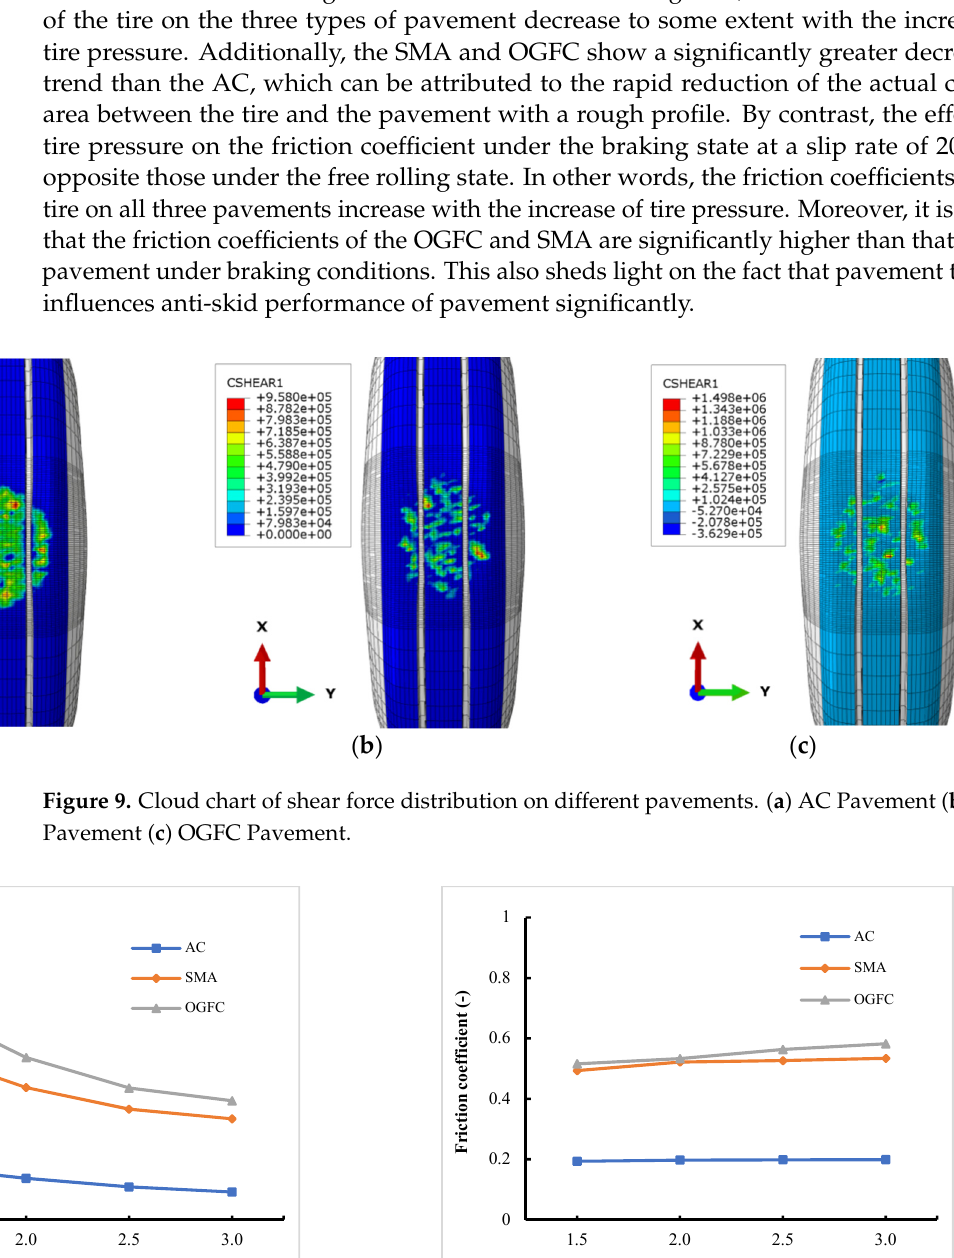
Figure 9. Cloud chart of shear force distribution on different pavements. ( a ) AC Pavement ( b ) SMA Pavement ( c ) OGFC Pavement.